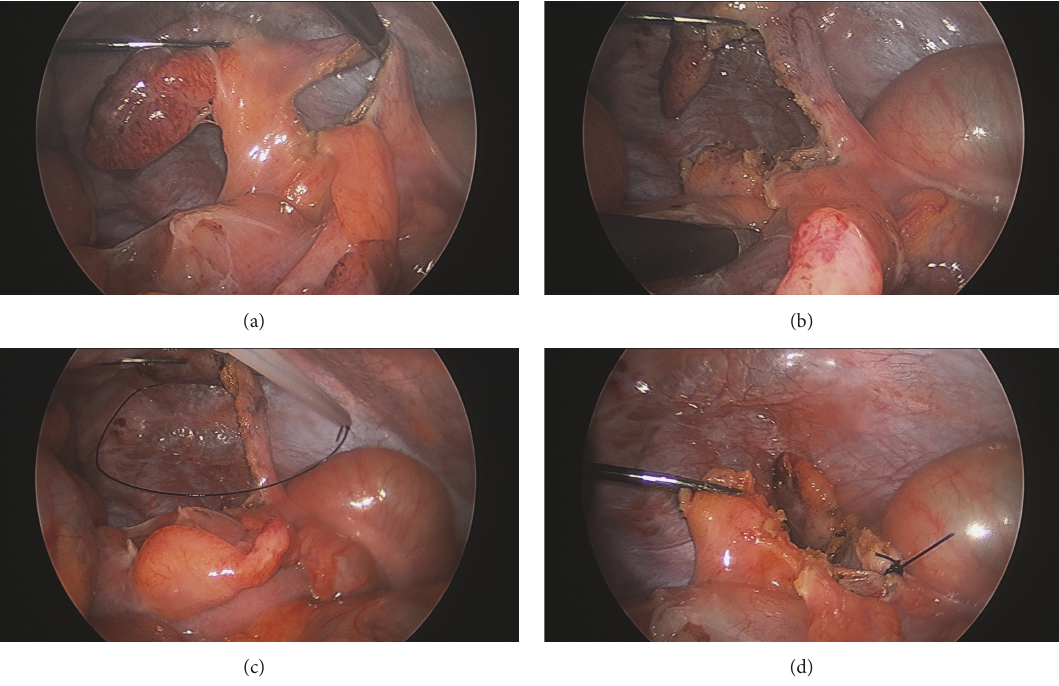
Figure 1: Laparoscopic appendectomy using two 5-mm ports and a needle grasper. (a) Phlegmonous appendix; window between appendix andmesoappendix. (b)Themesoappendixhas beencompletelydissected offtheappendix. (c)Anendoloop is lassoed aroundthe